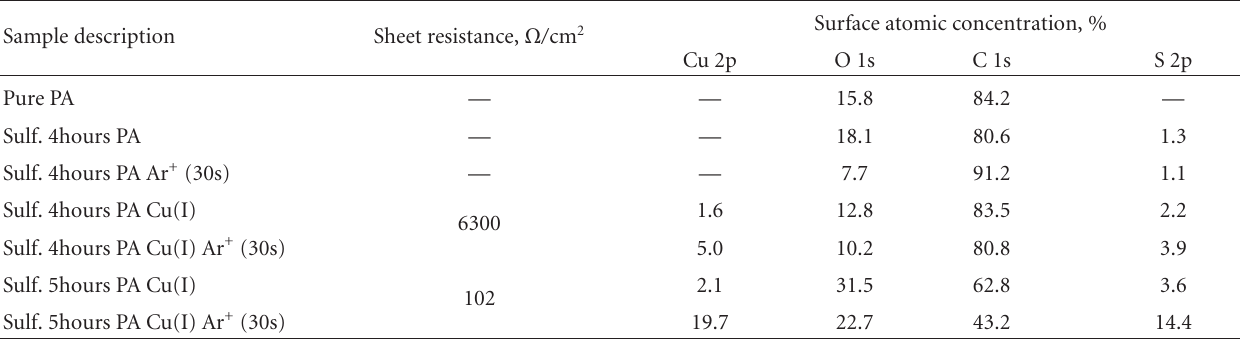
Table 2: The sheet resistance and surface atomic concentration calculation